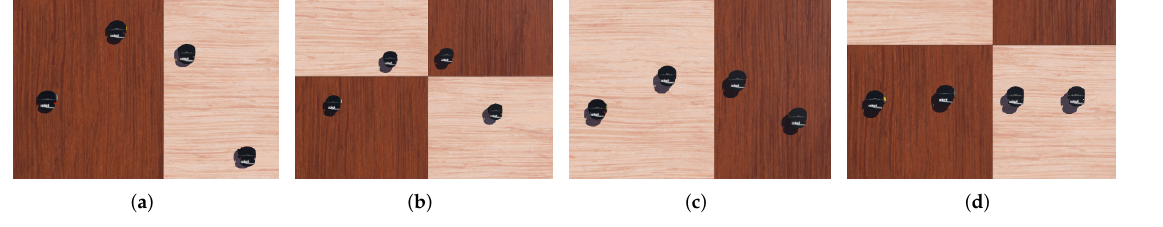
Figure 9. The formation shape of four robots at k = 0,20,35,75. ( a ) Formation shape ( k = 0). ( b ) Formation shape ( k = 20). ( c ) Formation shape ( k = 35). ( d ) Formation shape ( k =